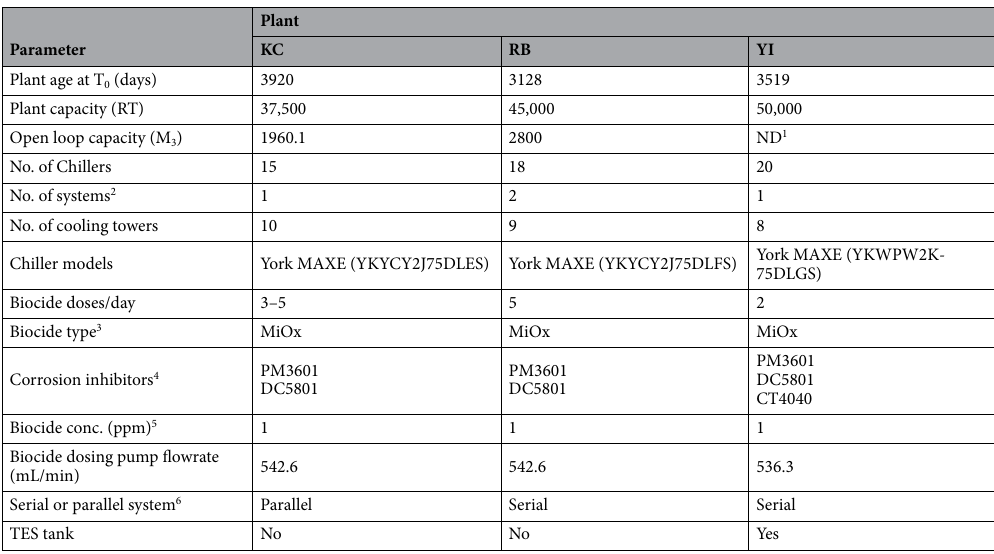
Table 1. Characteristics of the 3 DCPs sampled in this study. 1 ND—not determined. 2 Number of physically separated open loop systems (c.f. Fig. 1). 3 MiOx is the brand name of a system for on-site electrochemical generation and distribution of oxidative biocides in the open loop. 4 Product names for the corrosion inhibitors applied at site. 5 Intended concentration. 6 Configuration of water flow between chillers in the open